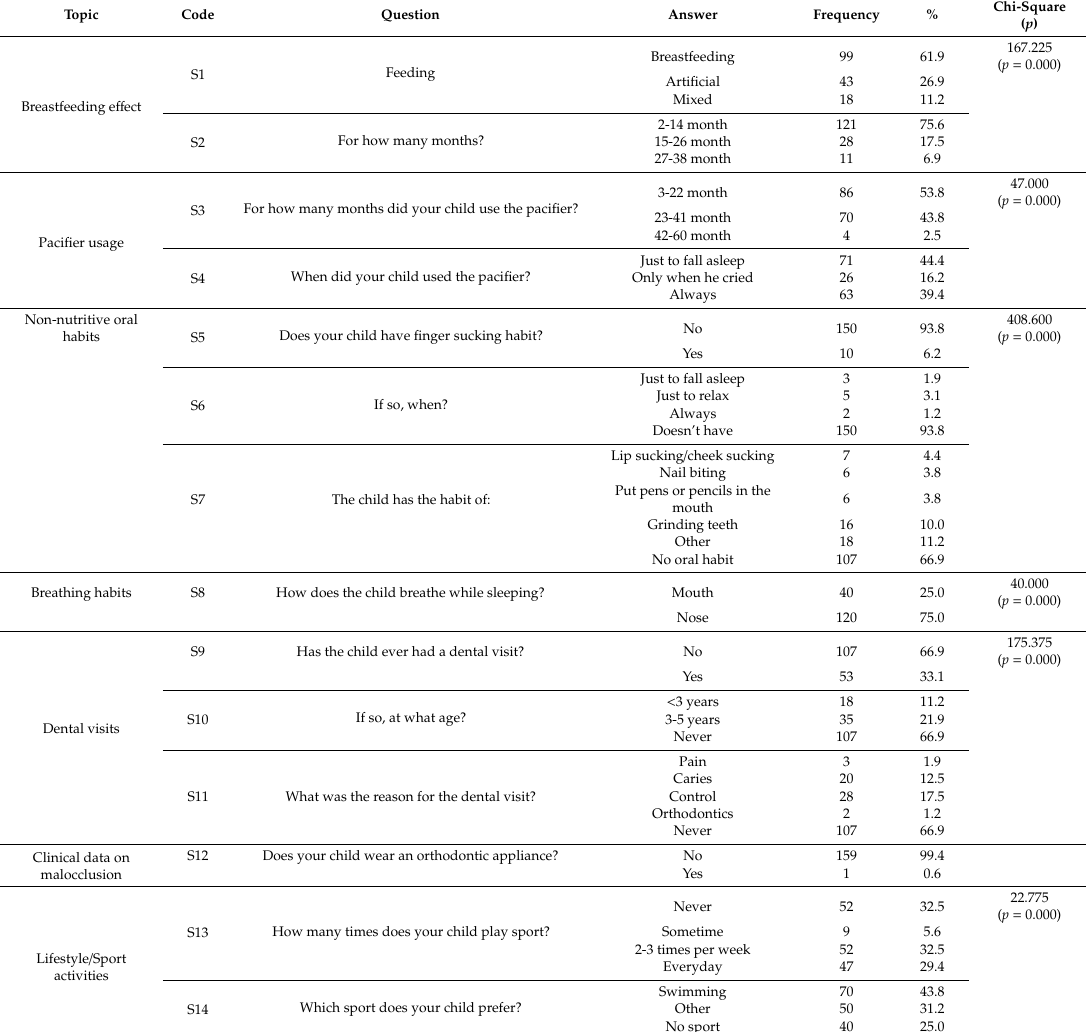
Table 2. Frequencies, percentages, and Chi-square values for each point of the questionnaire. Topic Code Question Answer Frequency % Chi-Square ( p )